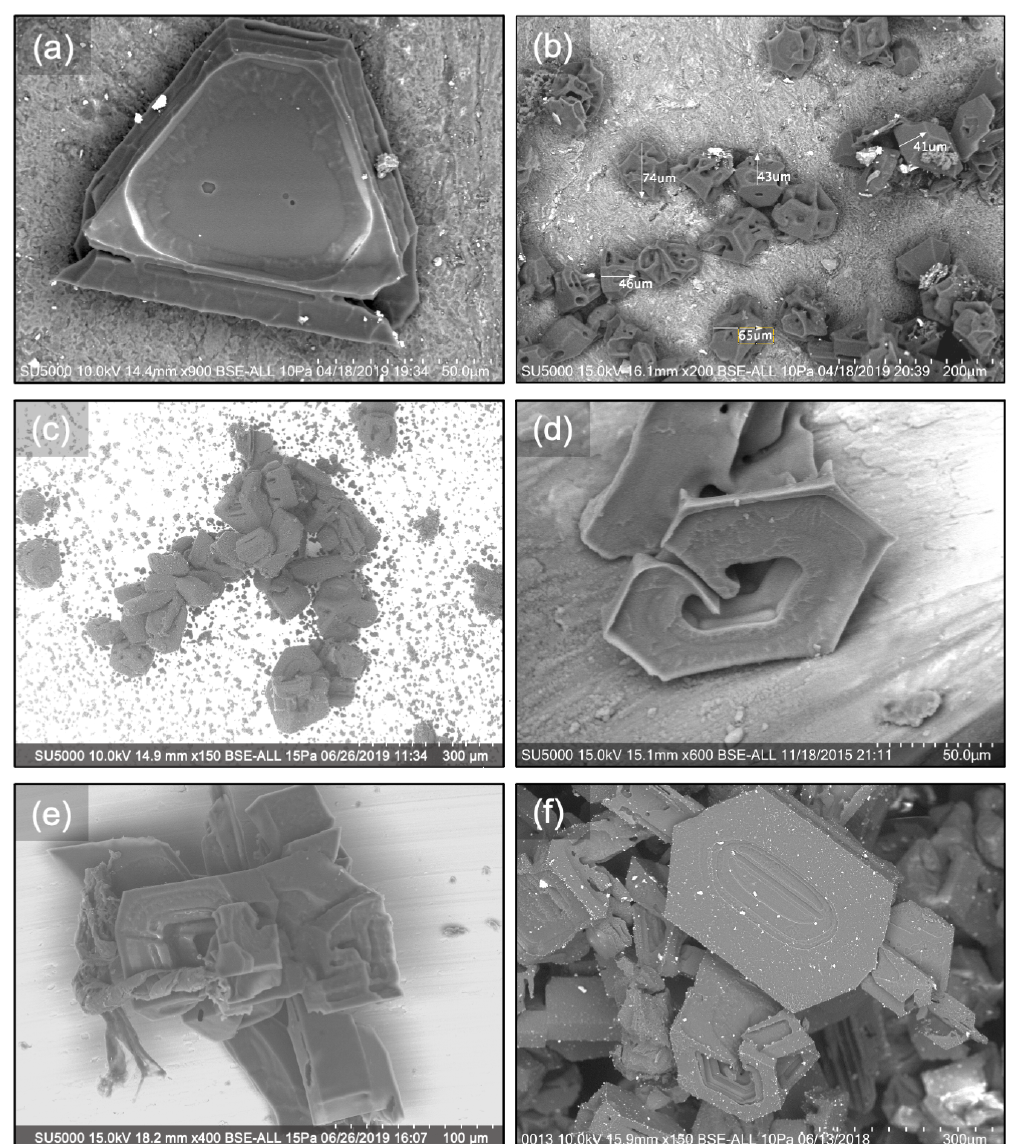
Figure 5. Ice particles with non-classical facet features. (a) Trigonal crystal with three six-sided etch pits, moderate roughening, and aerosol loading. (b) Relatively small, compact ice crystals (mean diameter: ∼ 55µm) with convoluted hollowing patterns and moderate mineral dust aerosol load. (c) Curving chain of a ∼ 15-particle aggregate including rosettes, compact crystals, and outre polyhedra. (d) Moderately roughened, scrolled plate with corner fins. (e) Complex rosette with twisted biogenic particle (left side). (f) Flattened, patterned hexagon with many small adhered aerosols and outre polyhedron